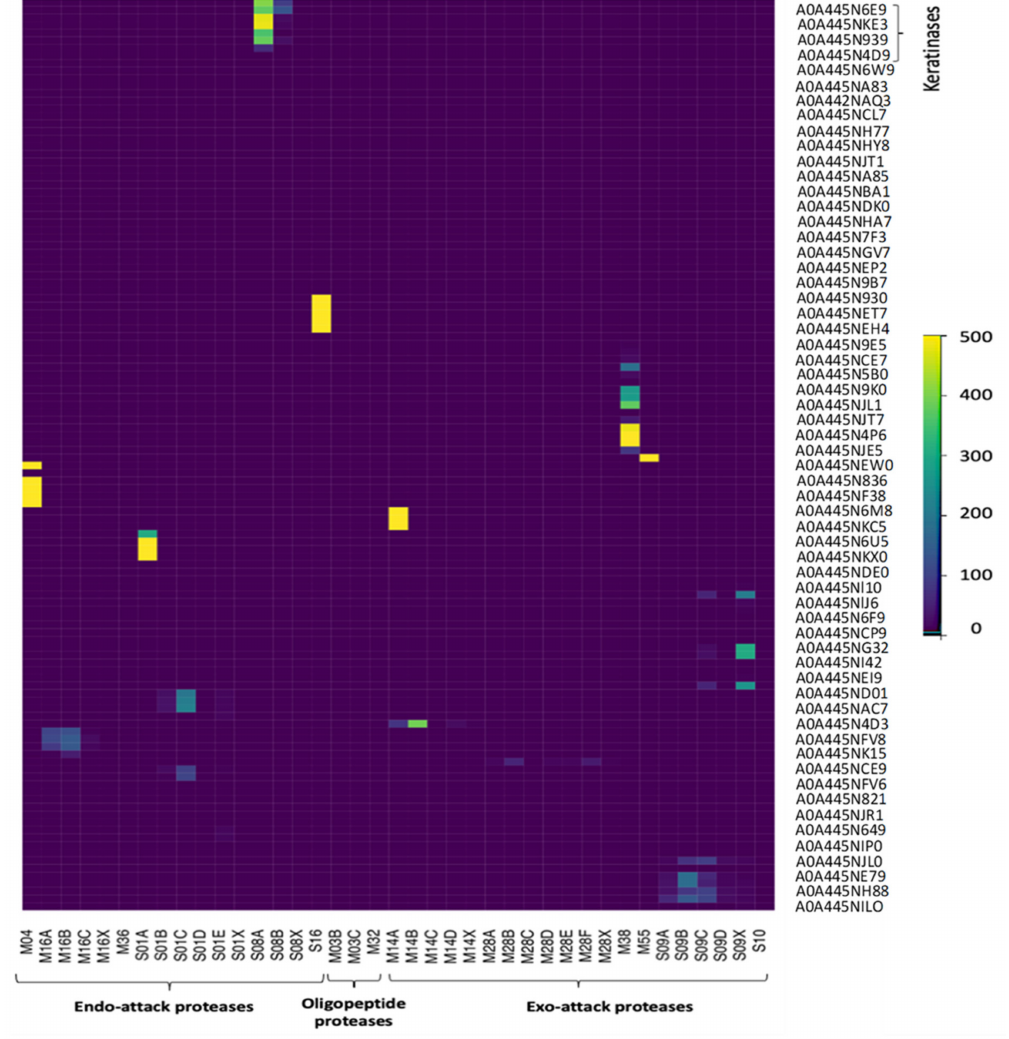
Figure 6. Detected proteases of S . netropsis .